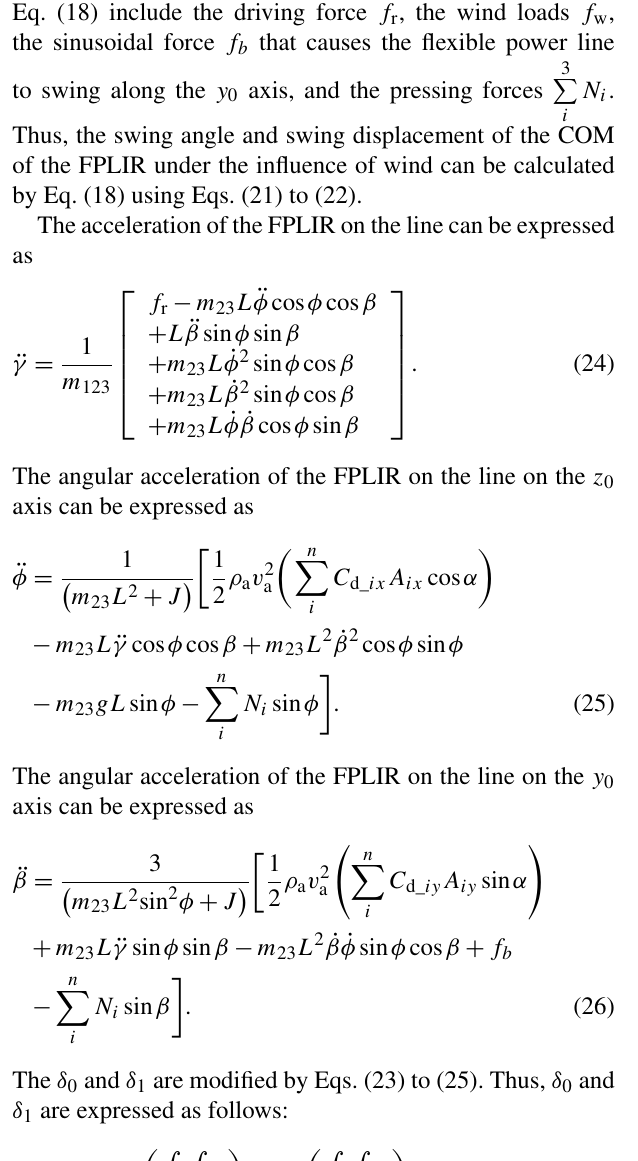
Table 2. Simulation parameters of the